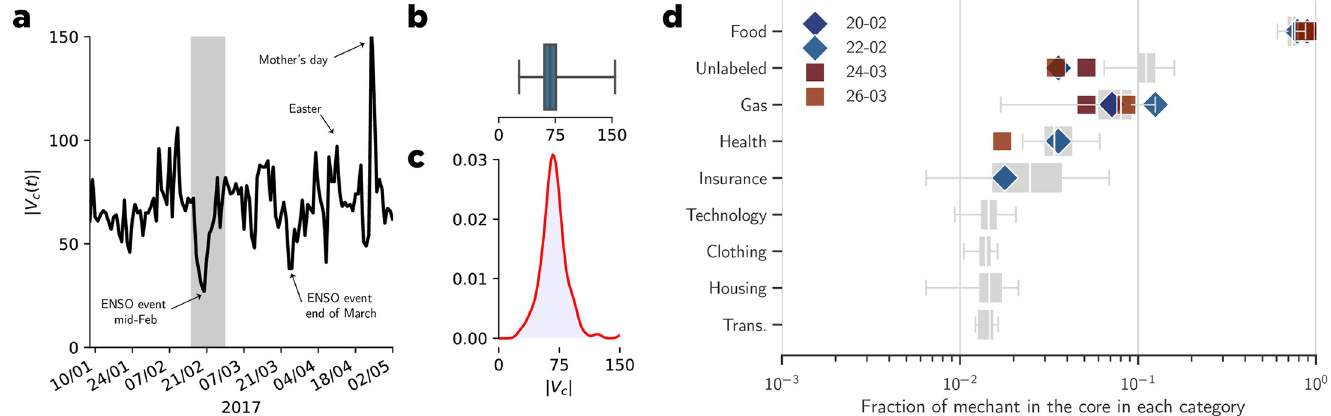
Fig 10. Evolution of the core structure of the transaction graph over time. a ) Temporal evolution of the size of the core structure of the transaction graph. b ) Boxplot of the core size distribution. c ) Core size distribution approximated by kernel density estimation. d ) Fraction of merchants that belong to the core nodes split by categories, the diamond represents the category split during the first ENSO event of February, whenever the square represents the second event of end of March.